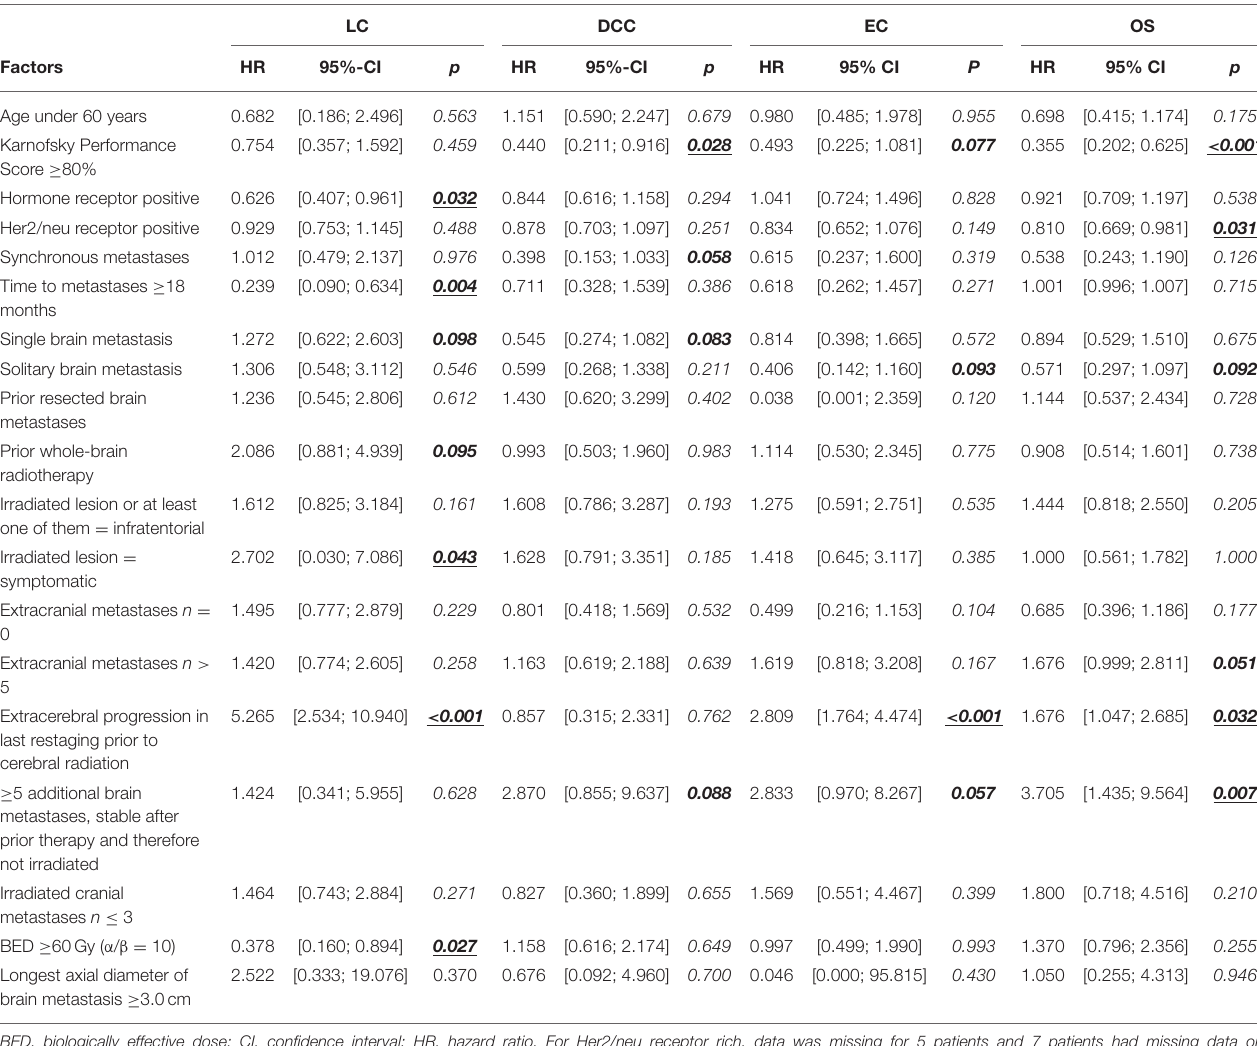
TABLE 6 | Univariate analysis of prognostic factors influencing local control (LC), distant cranial control (DCC), extracranial control (EC), and overall survival